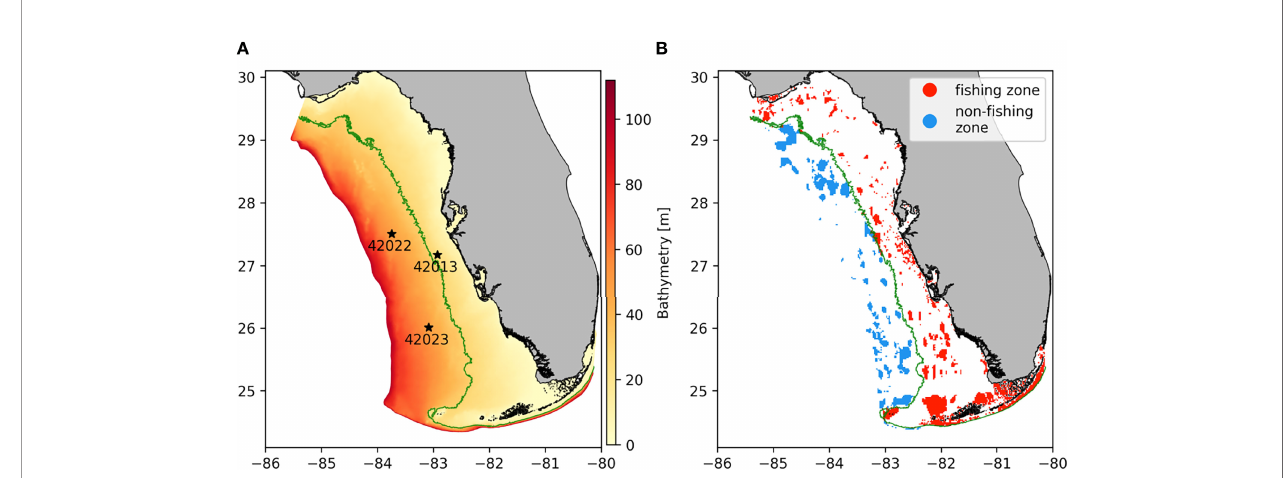
FIGURE 1 | Model computational domain with (A) the bathymetry and location of validation stations for the hydrodynamics (black stars) and (B) the stone crabs ’ habitats and their distribution between fi shing and non- fi shing zone. The green line represents the 30m